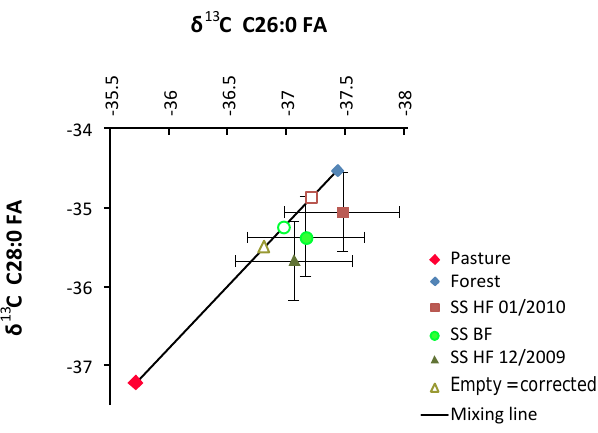
Figure 2. δ 13 C of the FAs C26:0 and C28:0 in suspended sedi- ments (SS) of two high flow (HF) and one base flow (BF) events and the two possible sediment sources from the land-use types pasture and forest at site A. Considering measurement uncertainty, δ 13 C were corrected to the mixing line. Error bars of SS display the mea- surement error of